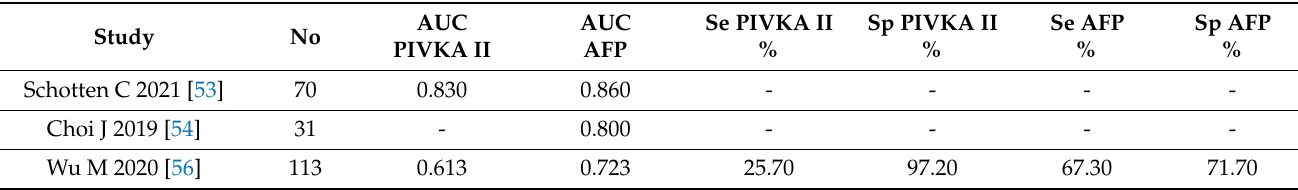
Table 3. Early HCC—Accuracy of AFP, PIVKA II for early HCC